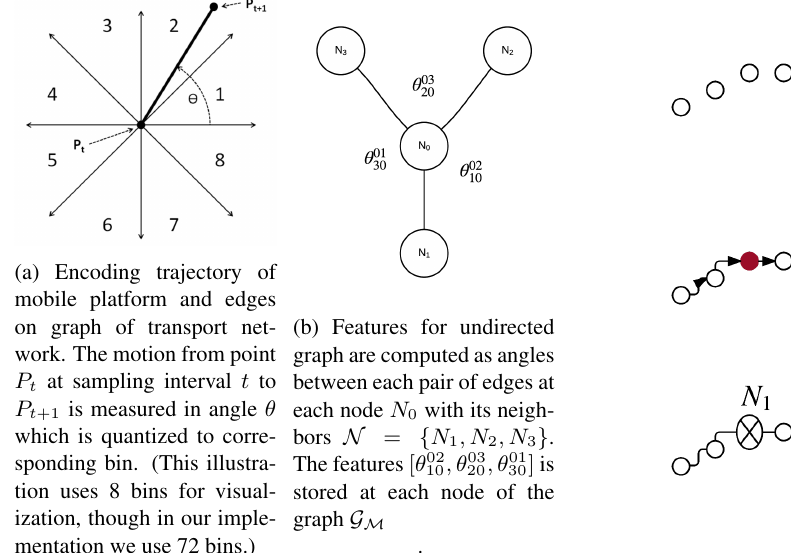
Figure 3: Encoding mobile platform trajectory and graph.